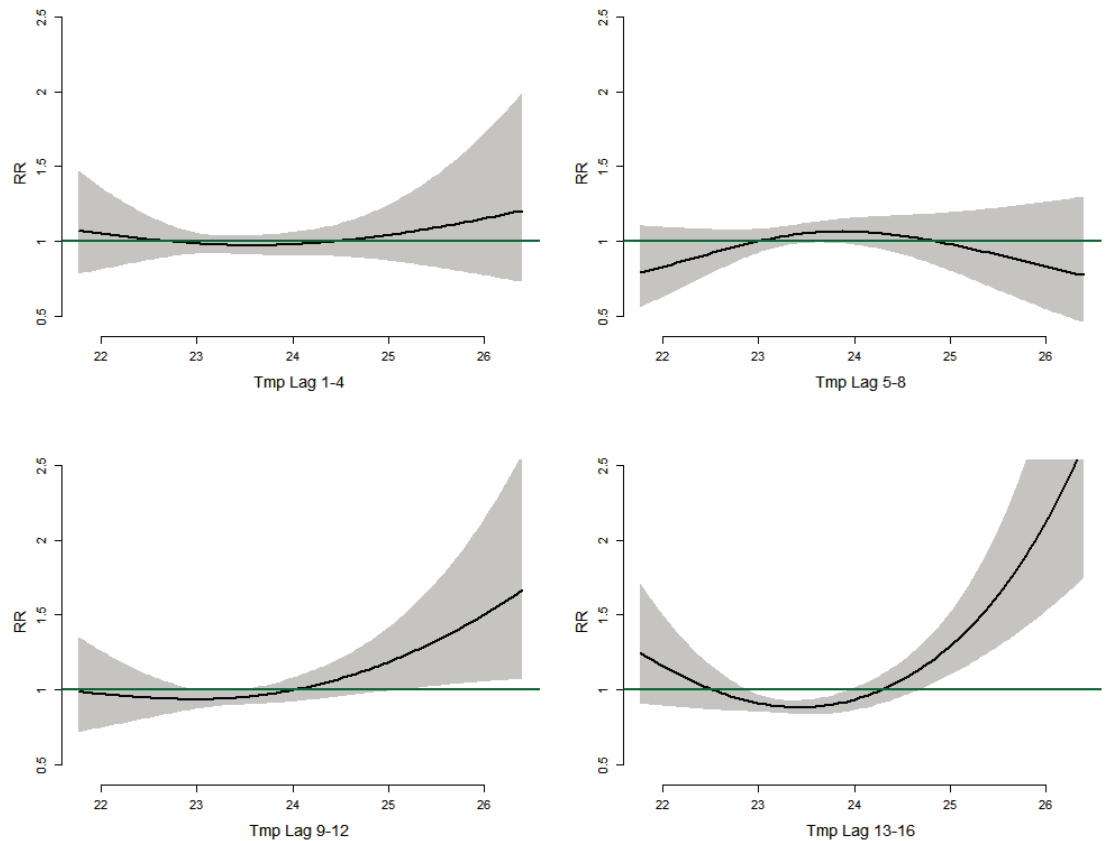
Figure 3. Relative risks of Malaria/Anemia mortality in children under five years with weekly mean temperature (Tmp) at different lag